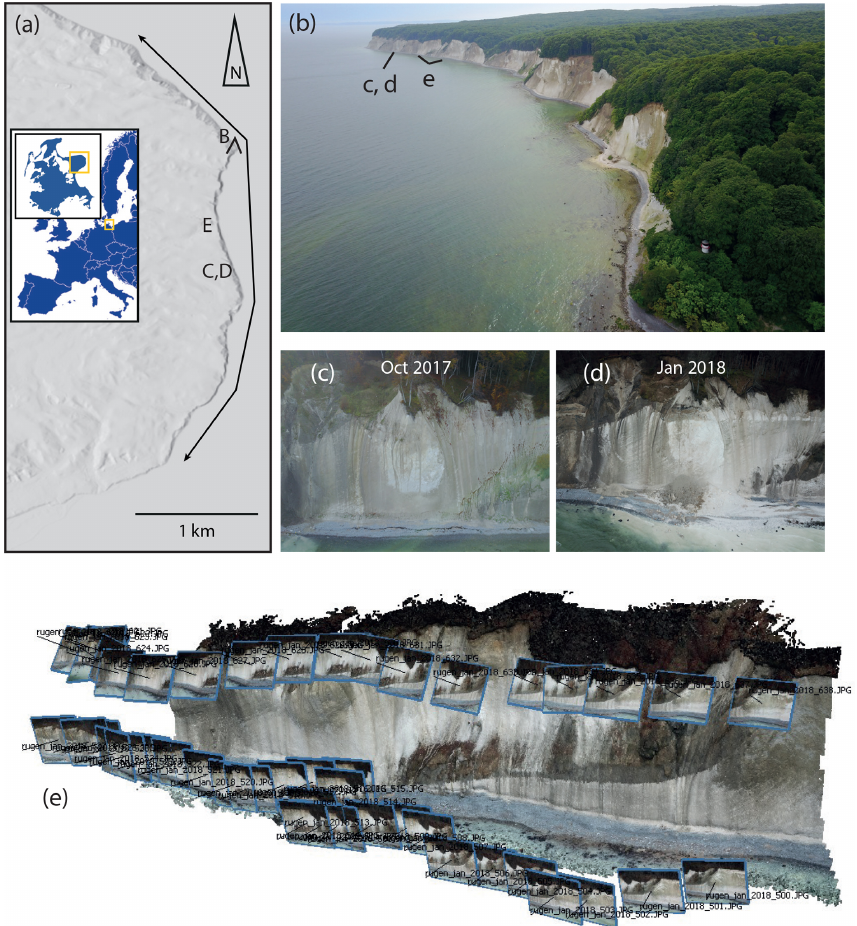
Figure 1. (a) Location of the Rügen study area, black line shows the studied coast section, and the locations of panels (b) – (e) are indicated. DEM is from the ALOS Global Digital Surface Model (AW3D30) ©JAXA. (b) Photo of the cliff coast in May 2018, view looking south. (c, d) Before and after photos of a cliff failure. (e) Example of survey geometry, with two passes at different altitudes and camera orientations, from January